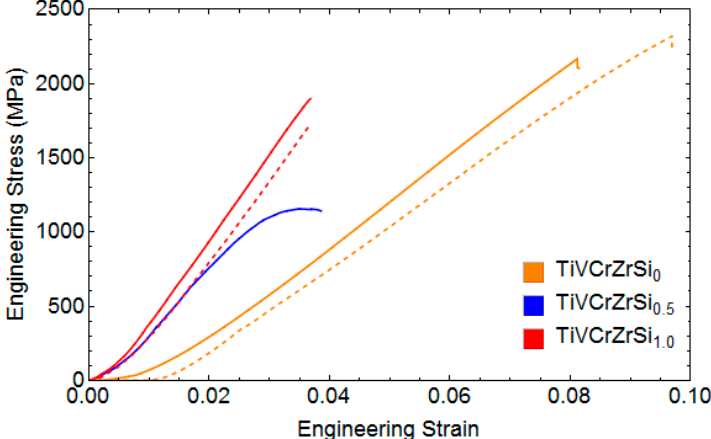
Figure 7. Stress-strain curves from compression testing of the alloys Si x TiVCrZr ( x = 0, 0.5, 1.0). The colour is used to indicate the alloy for each curve, with a dotted line used to show a repeat measurement (where these were possible).